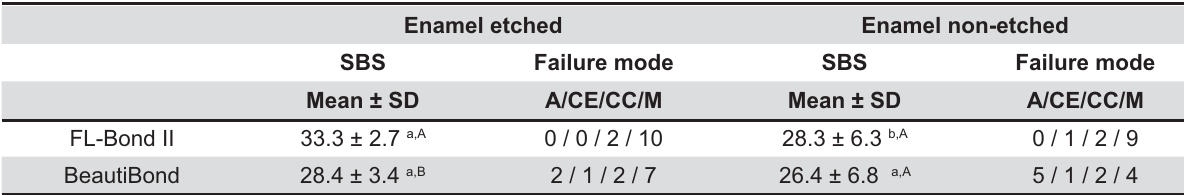
Table 2- Mean shear bond strength results and failure mode distribution for both adhesives applied to phosphoric acid- etched vs. non-etched enamel substrates (n=48). Modes of failure described as adhesive (A), cohesive in enamel (CE), cohesive in composite (CC), and mixed (M)